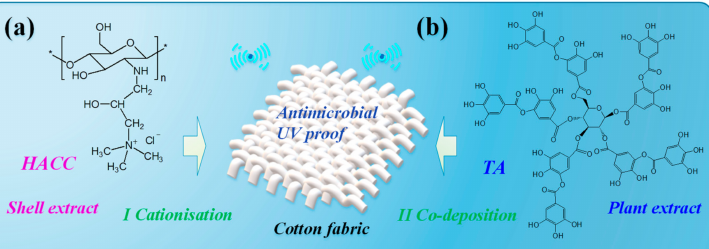
Figure 1. Ultrasonic-aided electrostatic co-deposition on cotton fabric using ( a ) HACC and ( b ) TA.